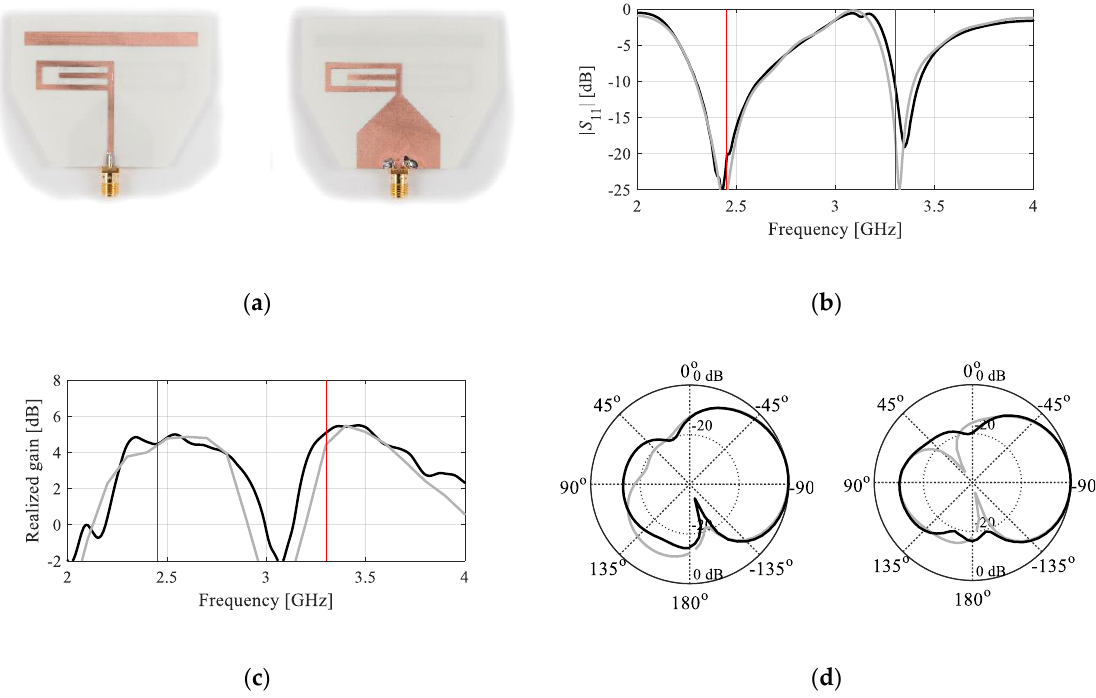
Figure 10. Antenna of Figure 6 optimized for f 1 = 2.45 GHz, f 2 = 3.3 GHz: ( a ) photographs of the prototype, ( b ) reflection | S 11 |, ( c ) end-fire realized gain, ( d ) yz -plane radiation pattern at both operating frequencies (2.45 GHz and 3.3 GHz on the left- and right-hand-side, respectively). Simulated and measured characteristics shown in gray and black,